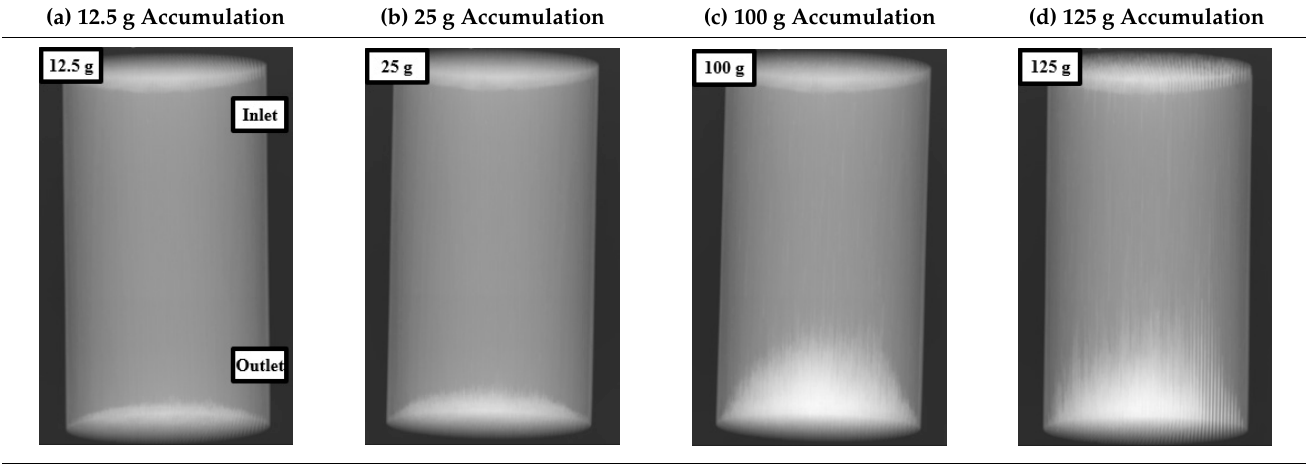
Table 7. The substrate images of four different conditions (ash powder from 12.5 g to 125 g).